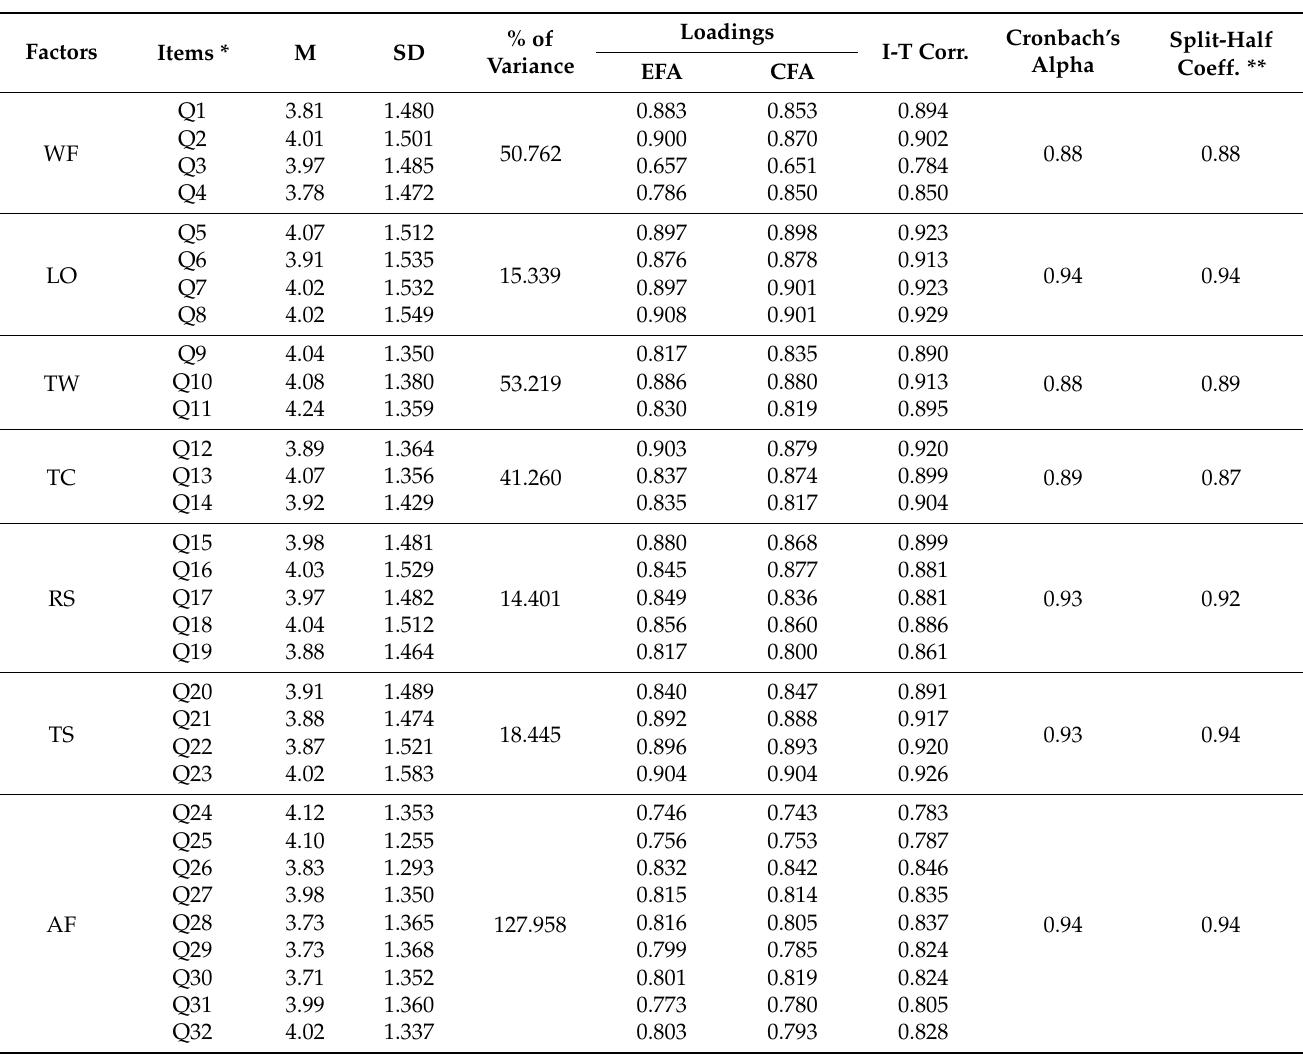
Table A1. Factor analysis and internal consistency of the Organizational Engagement Questionnaire ( n = 8403 via Internet survey in